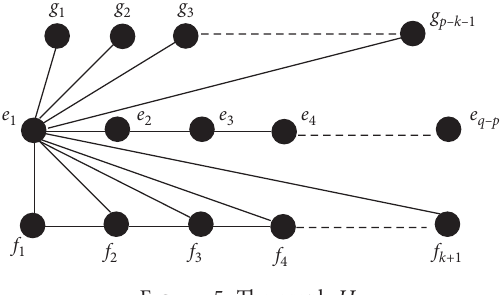
( G ) > β ( G ) . Figure 5: The graph H 5 se 6 se